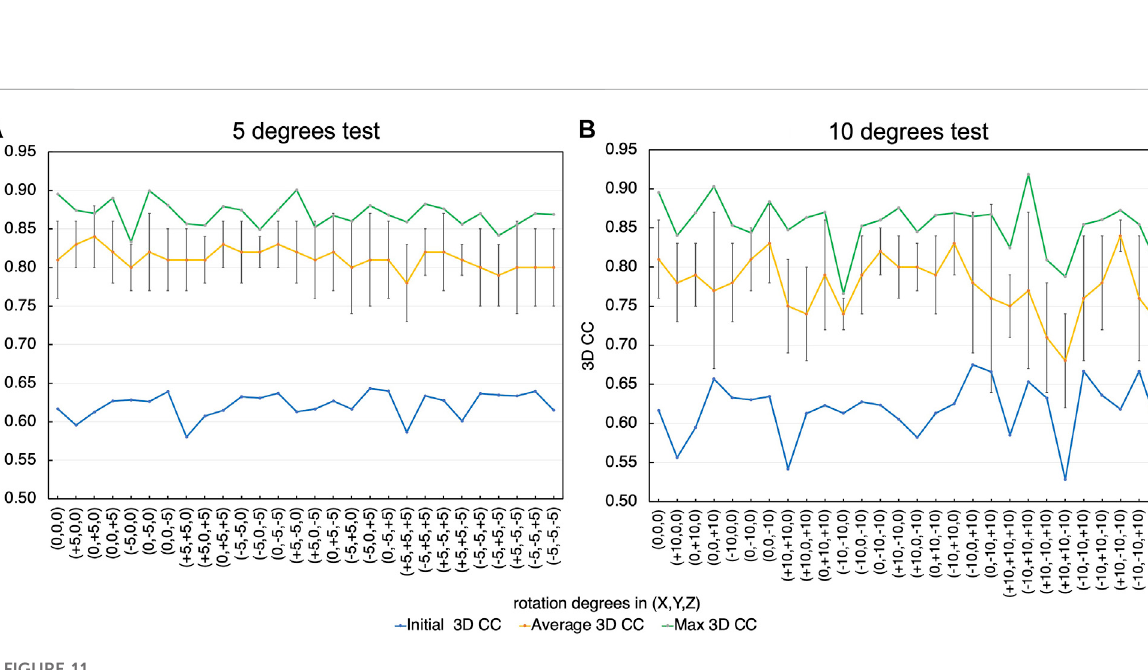
FIGURE 11 Effect of orientation errors (misalignment) of the initial conformation in relation to the target conformation on the modeling accuracy. (A) Rotation by − 5, 0, and 5 degrees. The initial 3D CC for each orientation (blue), the average (yellow) and the standard deviations (error bar), and the highest (green) of the fi nal 3D CC values are shown. (B) Rotation by − 10, 0 and 10